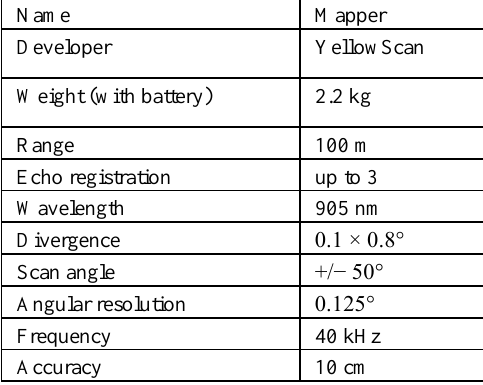
Table 2. Selected parameters of the LiDAR YellowScan Mapper The theoretical scanning density may achieve up to 600 points per square metre; however, it depends on the altitude and speed